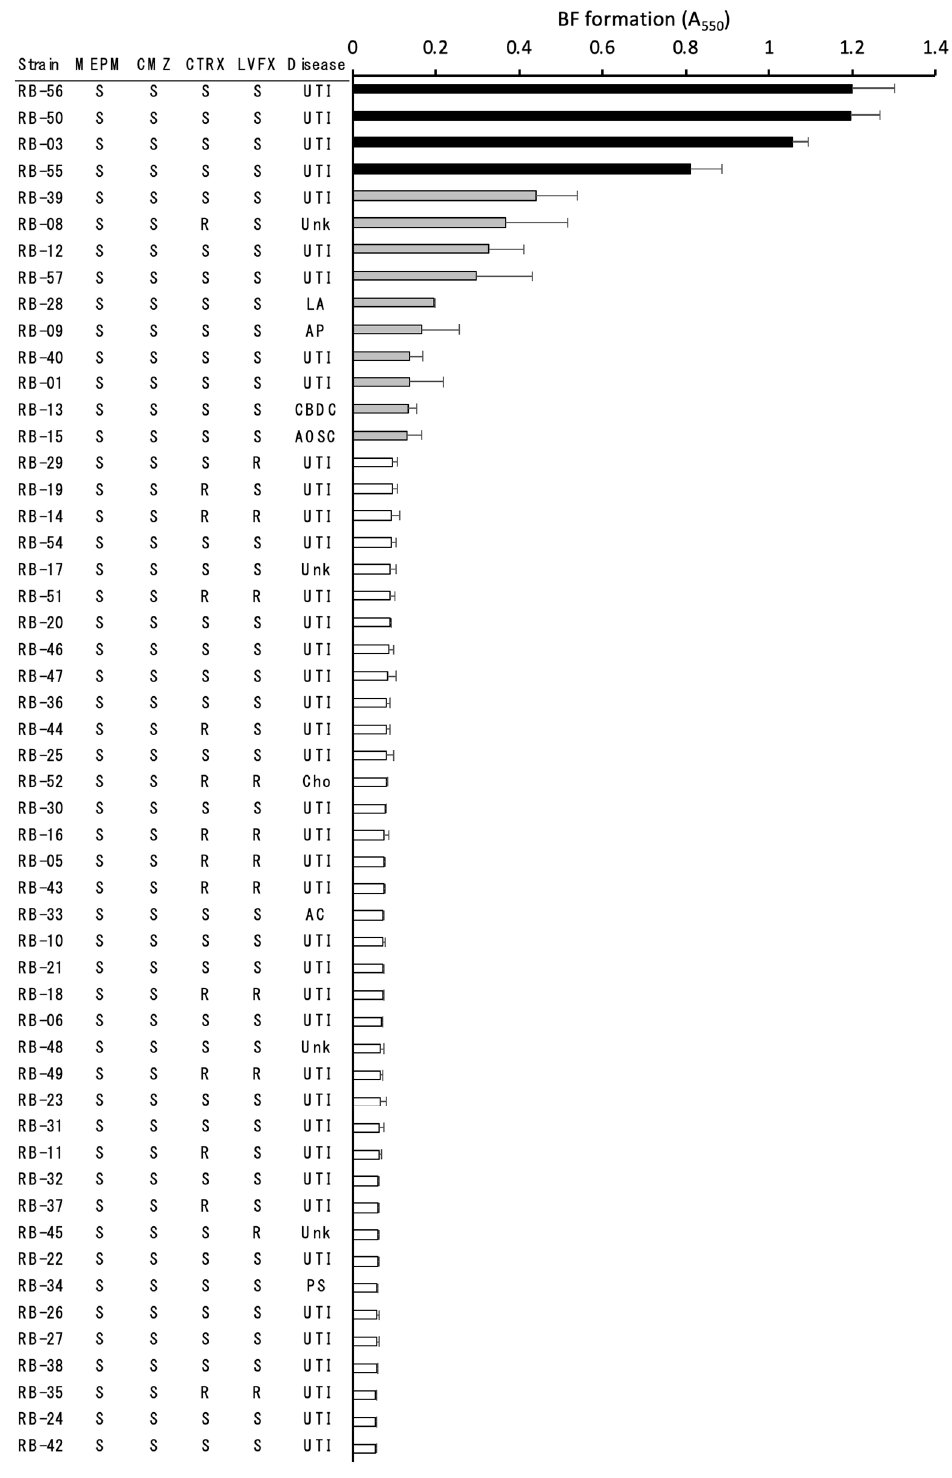
Figure 1. Biofilm-forming capacities and drug susceptibilities of E. coli clinical isolates. Black, gray, and white bars indicate high-capacity (A 550 > 0.8), low-capacity (A 550 0.1–0.8), and non-biofilm-forming strains (A 550 < 0.1), respectively. Measurements were performed three times, and the data shown are the means ± standard deviations. Antimicrobial drug susceptibilities from left to right: meropenem (MEPM), cefmetazole (CMZ), ceftriaxone (CTRX), and levofloxacin (LVFX) of planktonic E. coli cells; the primary diseases are shown next to the strain numbers. AC, acute cholangitis; AOSC, acute obstructive suppurative cholangitis; AP, acute prostatitis; CBDC, common bile duct calculi; Cho, cholecystitis; LA, liver abscess; PS, pyogenic spondylitis; Unk, Unknown; UTI, urinary tract